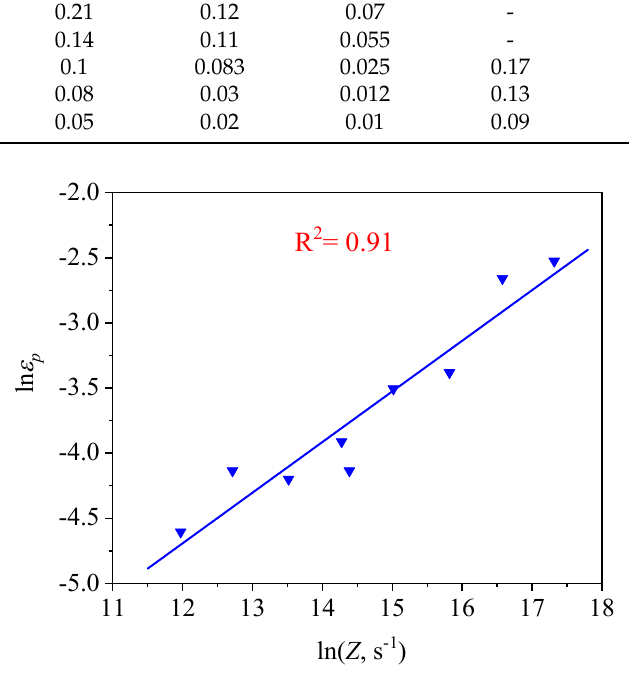
Figure 5. Relationship between the lnZ and ln ε p .